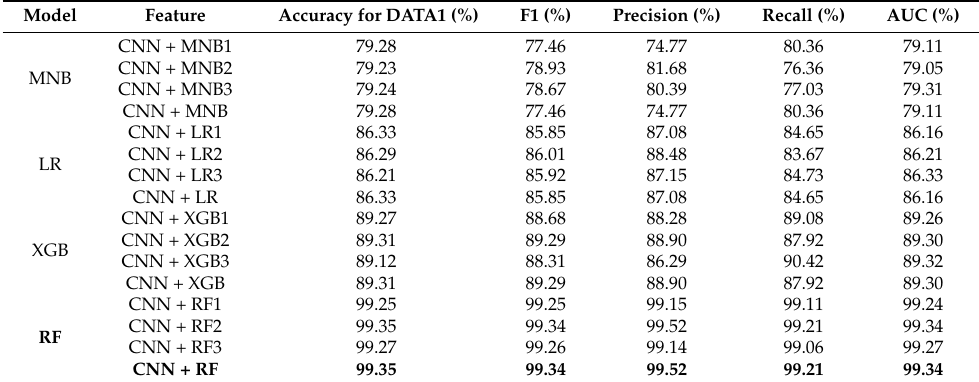
Table 7. Results of the classification models on D1.